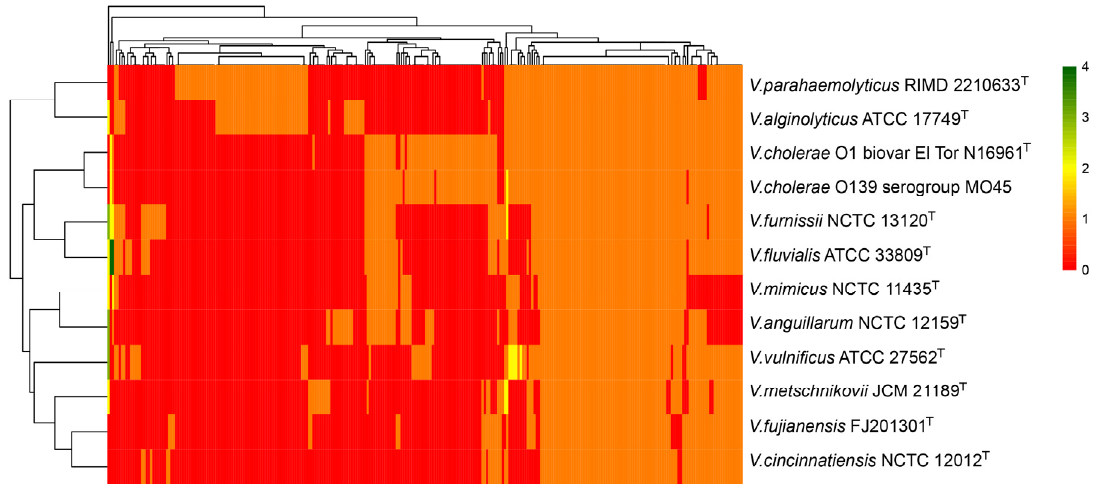
Figure 4. Two-dimensional hierarchical clustering analysis of putative virulence-associated genes based on the Virulence Factors Database (VFDB). Pathogenic Vibrio species are shown in the column and virulence factors are shown in the row. Different colors represent the corresponding number of virulence factors.